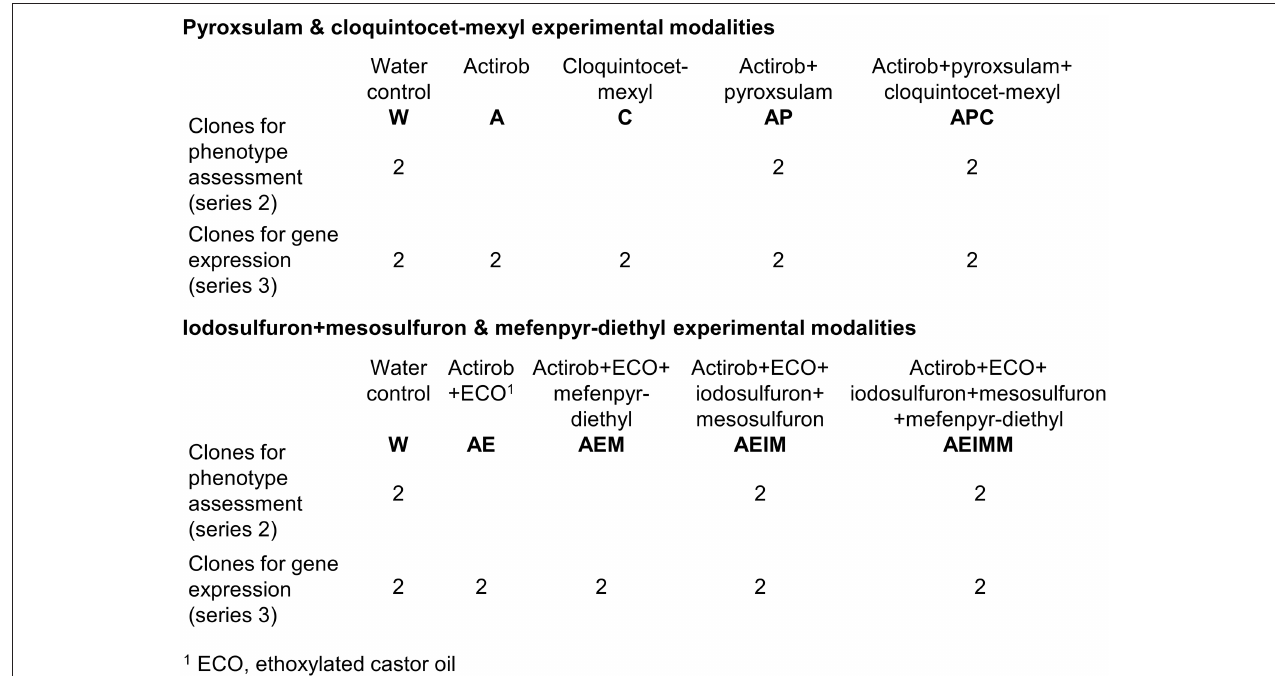
FIGURE 1 | Distribution of the 16 clones per rye-grass plant studied among the experimental modalities of the two series of spraying experiments used to produce plant material to investigate safener effect on individual plant phenotype (experiment series 2) and on NTSR marker gene expression (experiment series 3).